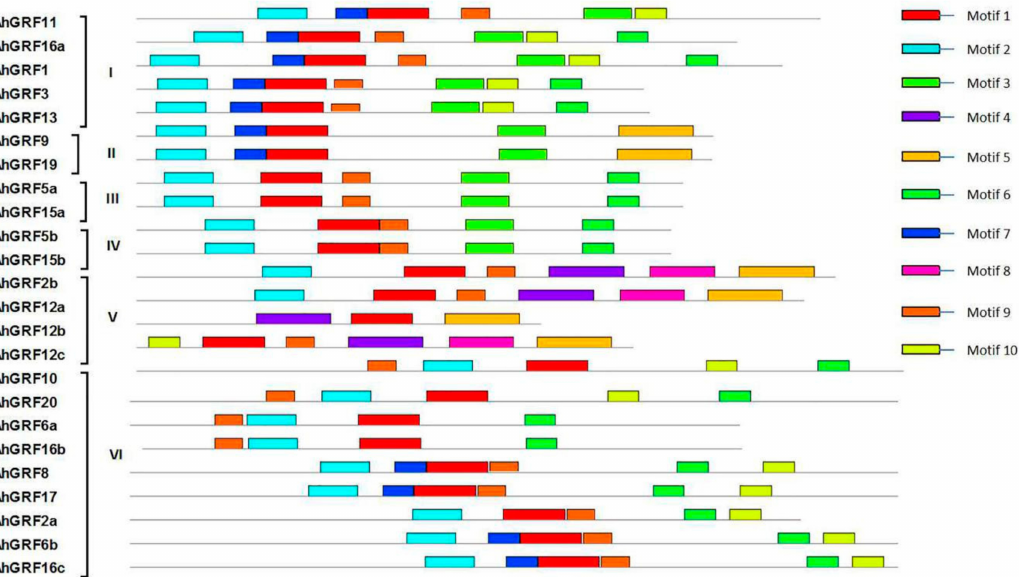
Figure 2. Distribution of conserved domains in AhGRF genes. Ten conserved motifs labeled with di ff erent colors were found in the AhGRF sequences using the MEME program. Among them, motif 1, motif 2, motif 4 and motif 6 are the QLQ, WRC, GGPL and FFD conserved domains. The sizes of motifs are proportional to their sequence